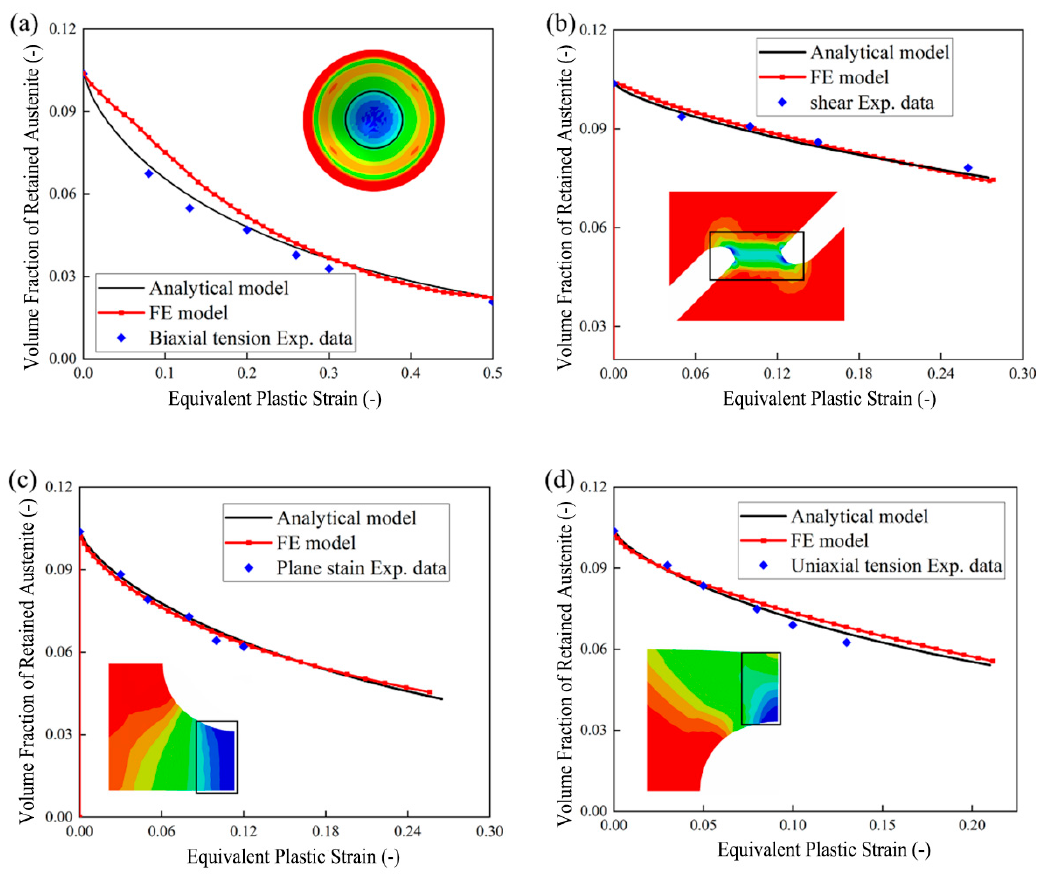
Figure 10. Comparisons of the VFRA using analytical and FE model: ( a ) Nakajima specimen; ( b ) shear specimen; ( c ) notched specimen; ( d ) central hole specimen.